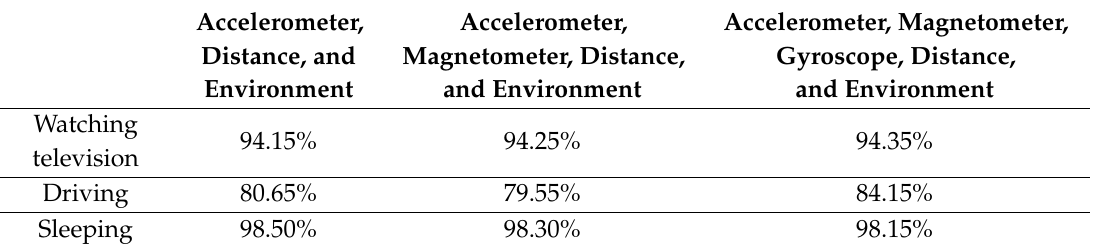
Table 22. Accuracies of the activities’ recognition without motion using using the DNN method for motion, magnetic, and location sensors after the recognition of the environment.